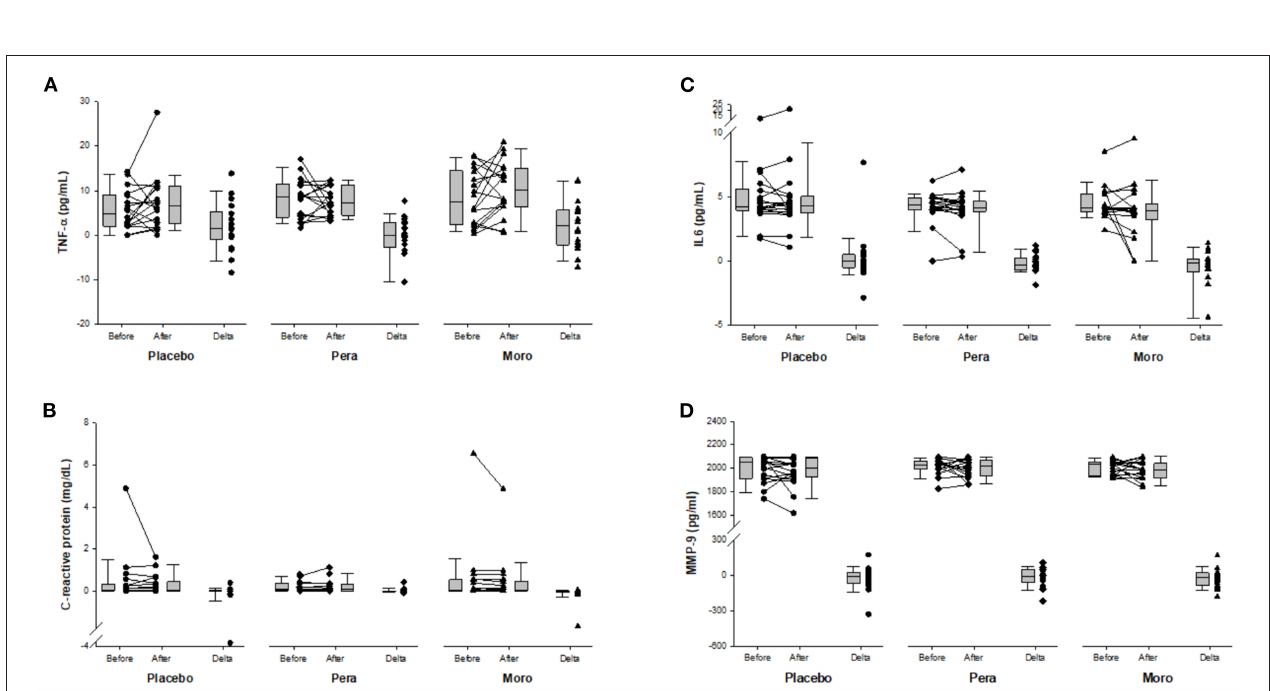
FIGURE 2 | (A) Comparison of serum TNF- α between Placebo, “Pera,” and “Moro” groups ( n = 18 patients per group). The delta values of the three groups were compared using the Kruskal-Wallis test ( p = 0.250). (B) Comparison of serum C-reactive protein between Placebo, “Pera,” and “Moro” groups. The delta values of the three groups were compared using the Kruskal-Wallis test ( p = 0.158). (C) Comparison of serum IL-6 between Placebo, “Pera,” and “Moro” groups. The delta values of the three groups were compared using the Kruskal-Wallis test ( p = 0.750). (D) Comparison of serum MMP-9 between Placebo, “Pera,” and “Moro” groups. The delta values of the three groups were compared using the Kruskal-Wallis test ( p = 0.843).